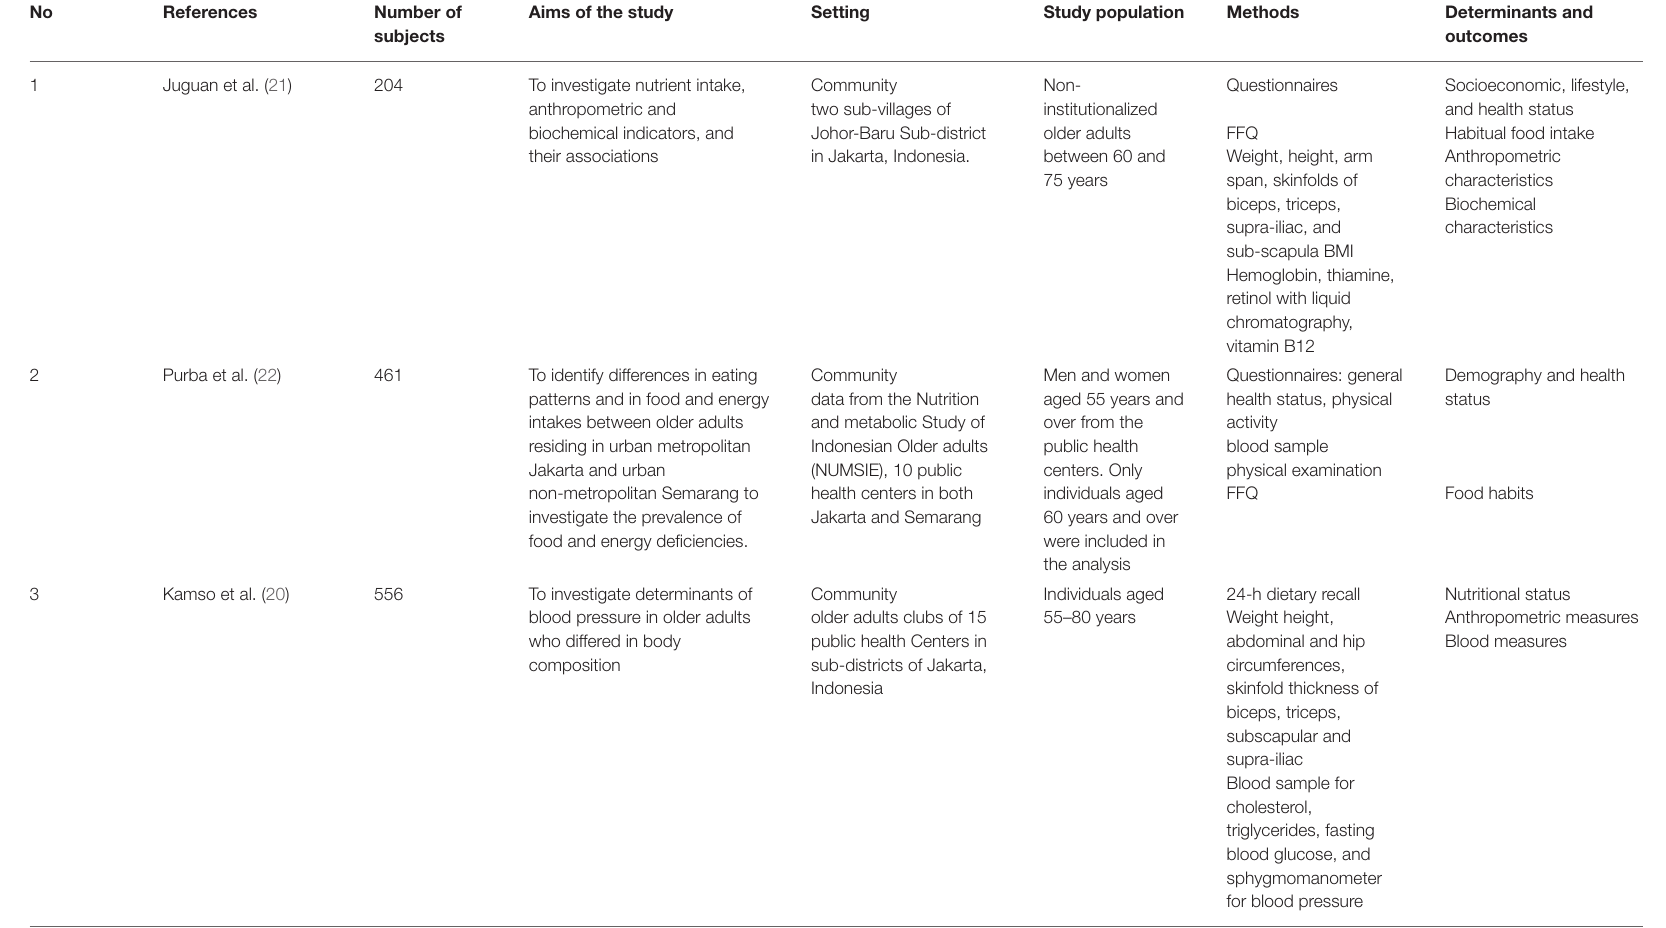
TABLE 1 | Descriptive characteristics of the included